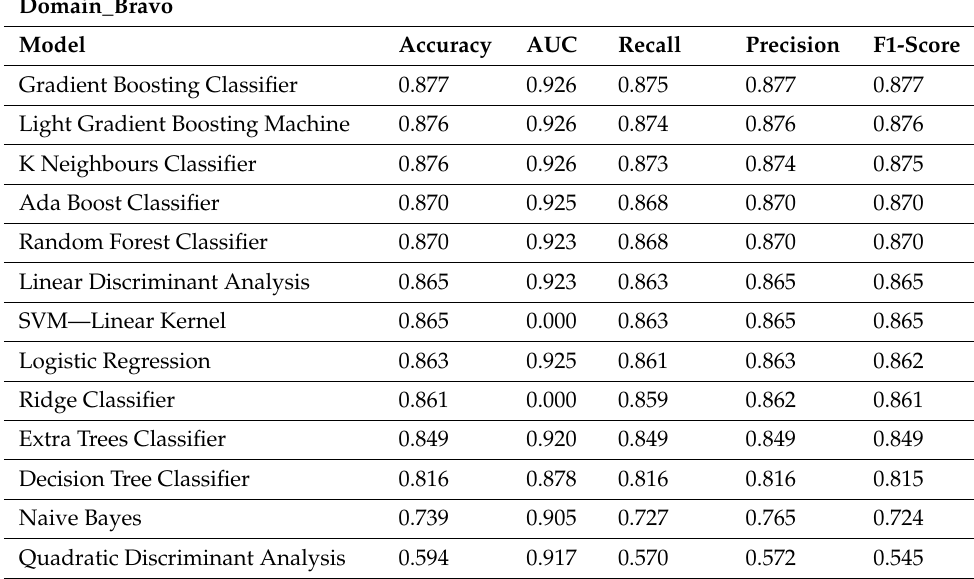
Table 3. The best model for the Domain